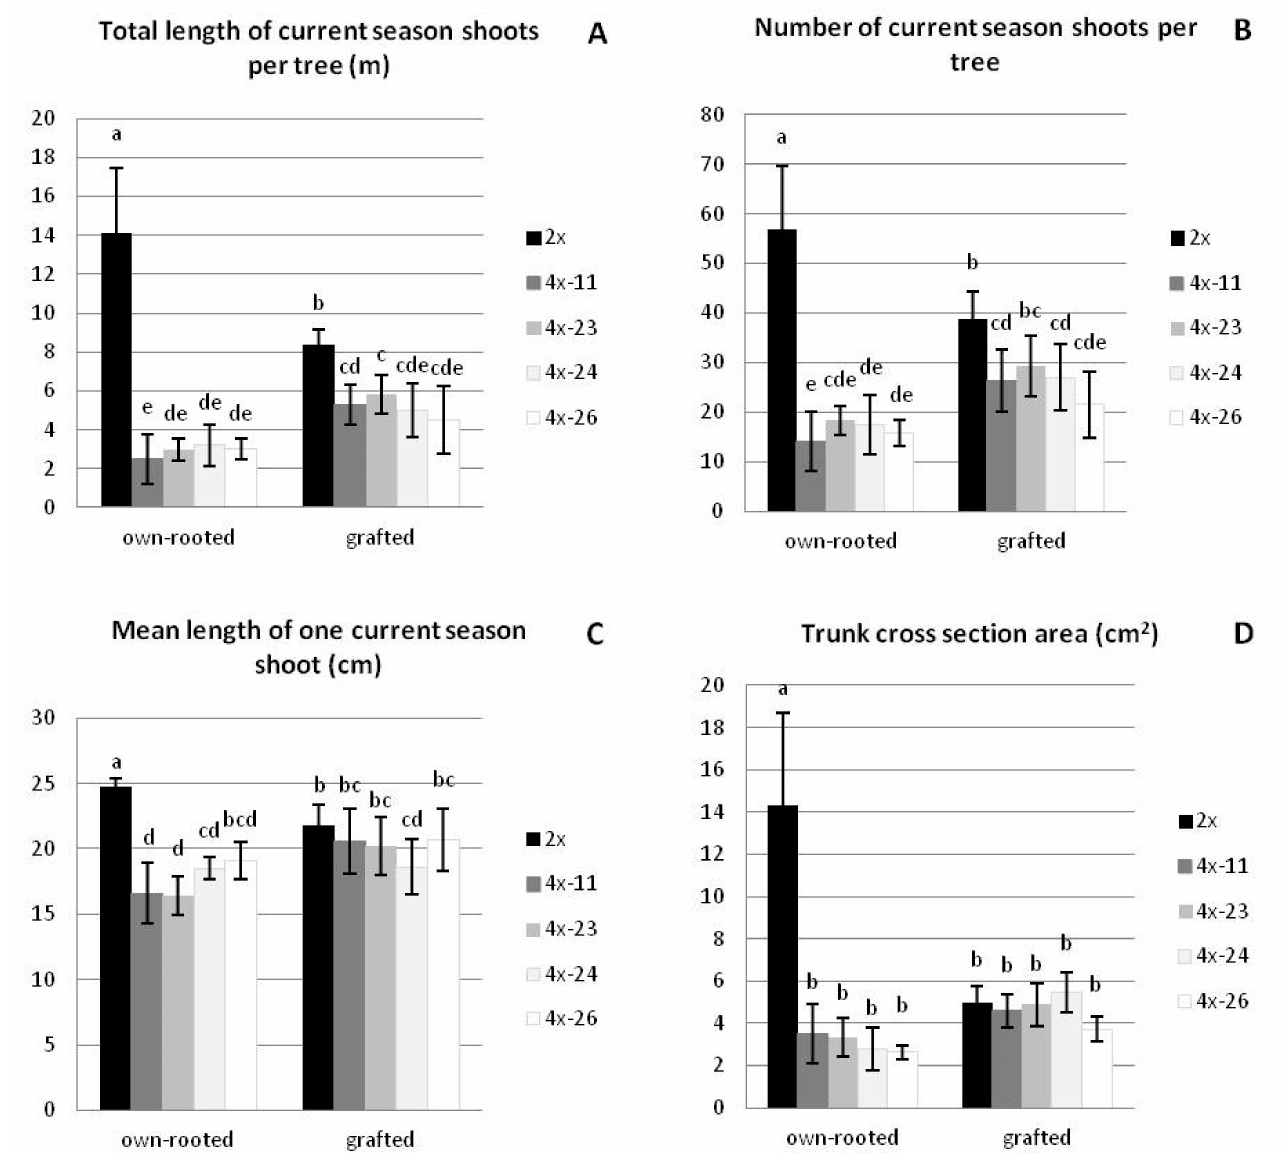
Figure 1. Growth parameters of the own-rooted and M9-grafted five-year-old trees of diploid (2x) and tetraploid clones (4x-11, 4x-23, 4x-24 and 4x-26) of the apple cv. ‘Redchief’ growing in an experimental orchard at the National Institute of Horticultural Research (Skierniewice, Poland): ( A ) total length of current season shoots, ( B ) number of current season shoots per tree, ( C ) mean length of one current season shoot, ( D ) trunk cross-section area. Bars marked with the same letter do not differ significantly at p = 0.05; Duncan’s